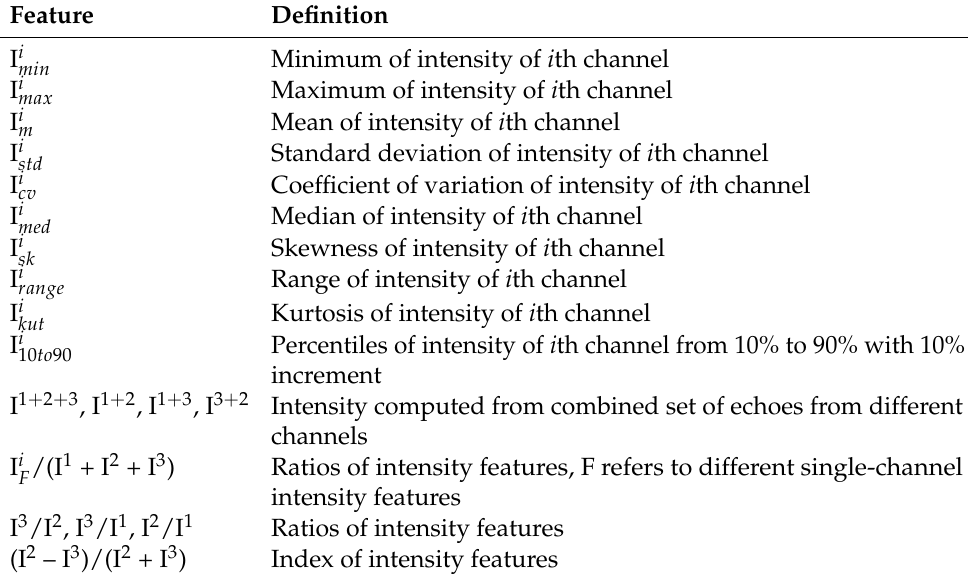
Table 3. Multi-channel intensity features derived from LiDAR